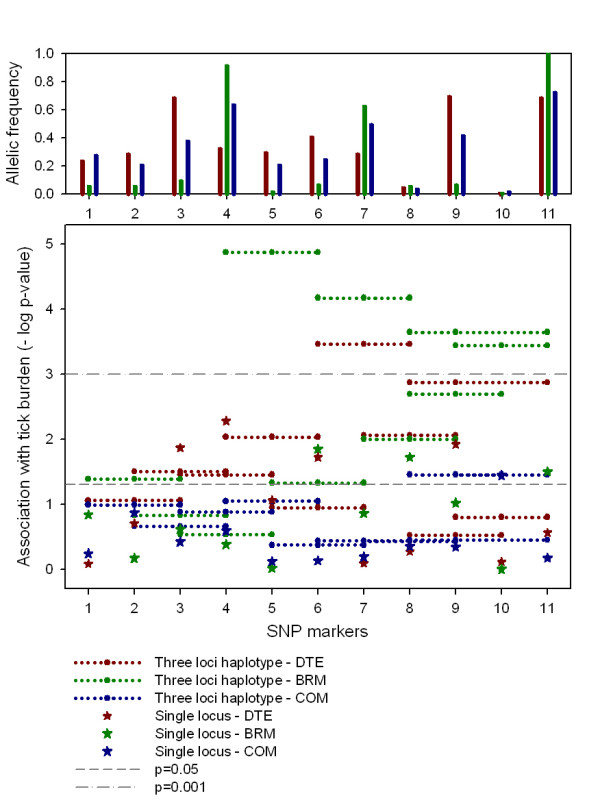
SNP markers at the ITGA11 gene region: allelic frequency and analyses of marker association with tick burden in the three populations. 1- rs29025980, 2- rs43616884, 3- rs29025985, 4- rs29025981, 5- rs41594962, 6-ss161109814, 7-ss161109807, 8- ss161109797, 9- rs29023635, 10- rs29023639, 11- rs29014770.